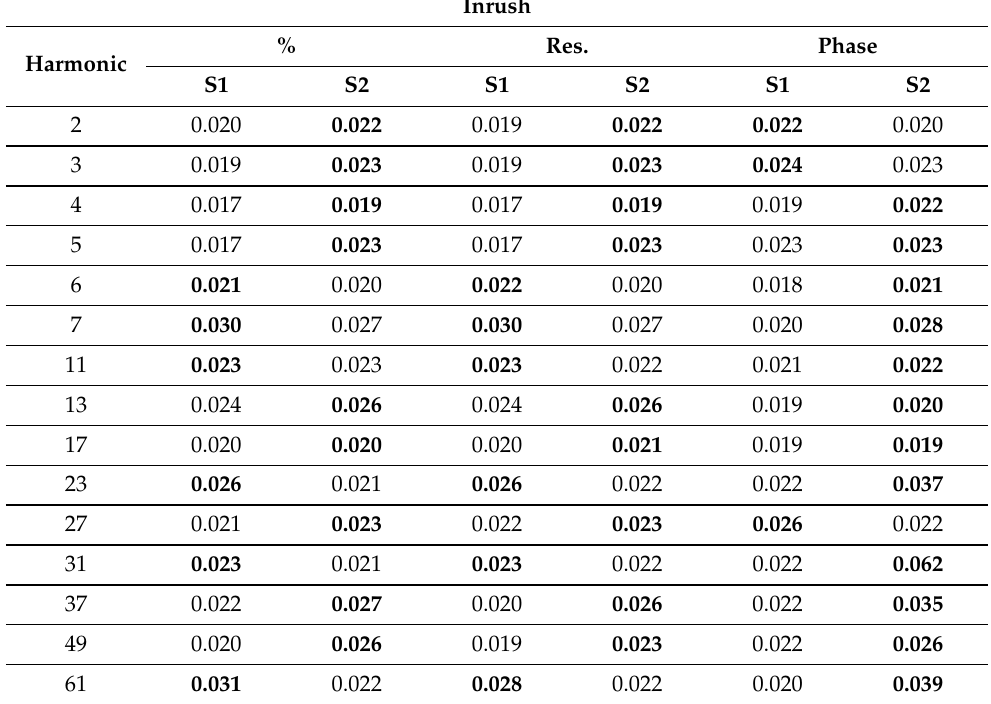
Table 5. RMSE for Inrush Harmonic Distributions.